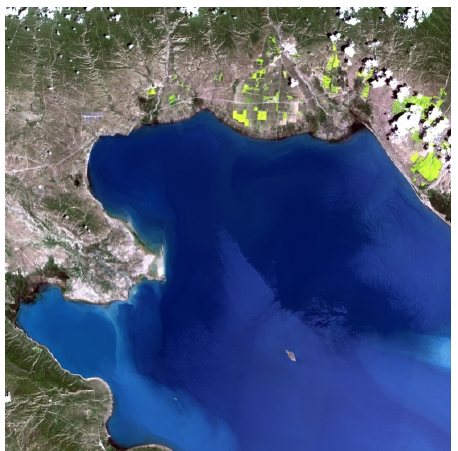
Figure 4. Landsat-8 OLI data in Qinghai Lake (Colour synthesis with band 4, band 3 and band